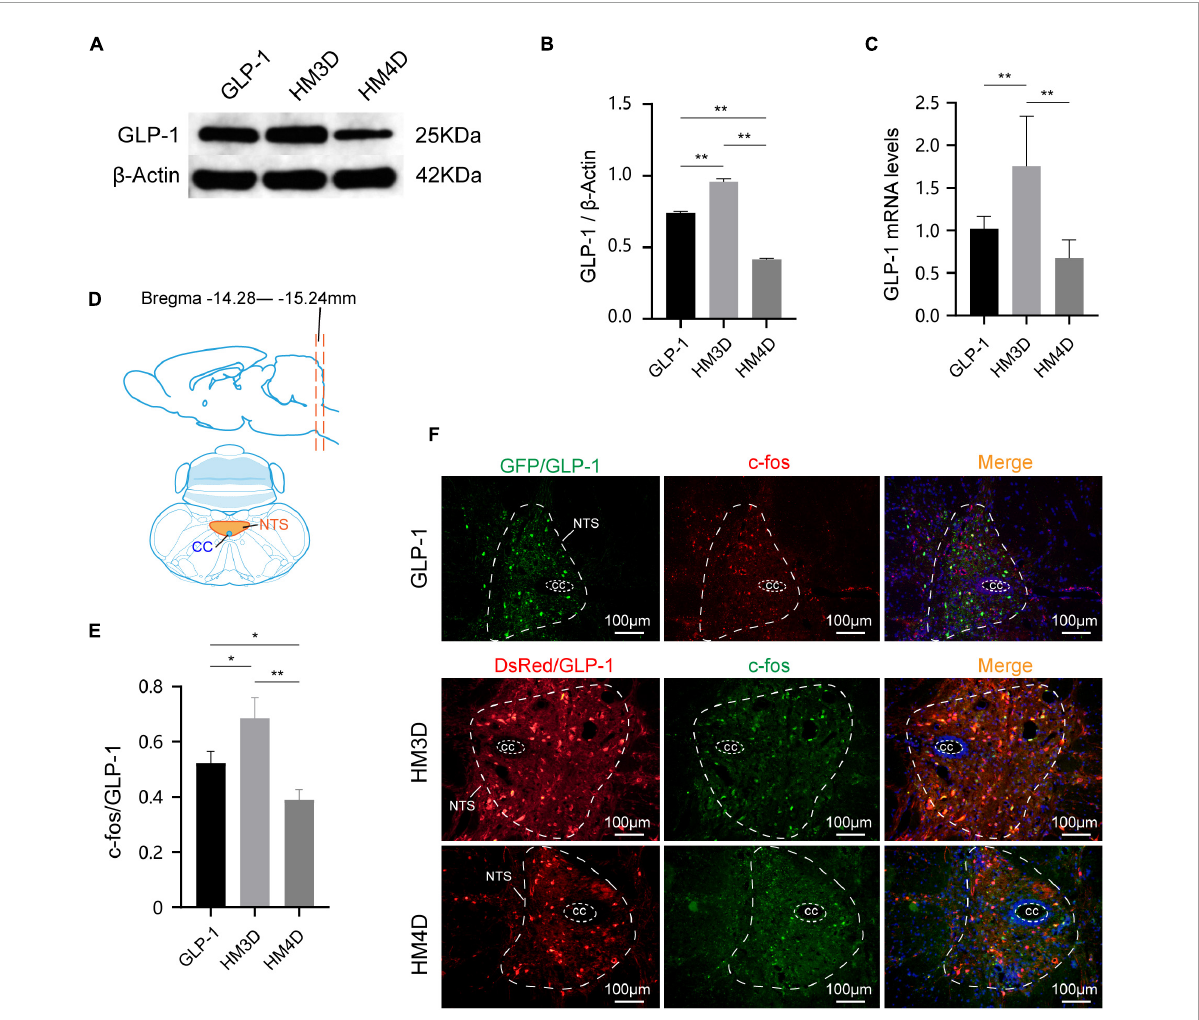
FIGURE6 Comparison of protein and gene expression of GLP-1 in NTS. (A,B) WB and protein expression of GLP-1in NTS; (C) gene expression of GLP-1 in NTS; (D) the slice range and localization pattern of the coronal plane where the NTS is located; (E) comparison of activation numbers of GLP-1 neurons in NTS; (F) representative figures of activated GLP-1 neurons in the NTS of rats in each group; * P < 0.05, ** P < 0.01. WB, Western blotting; GLP-1, glucagon-like peptide 1; cc, central canal; NTS, nucleus of the solitary